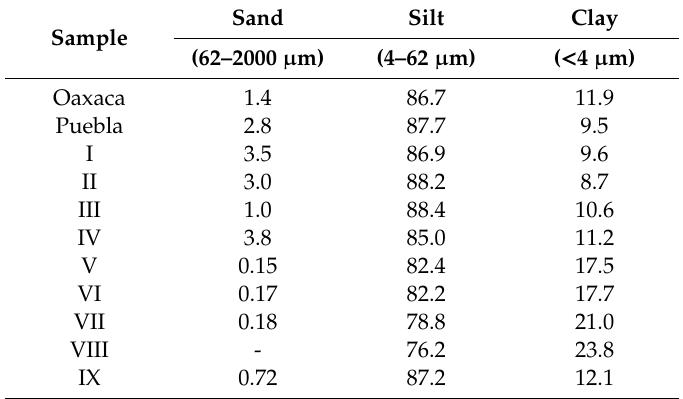
Table 4. Grain size distribution (%) of natural Mexican talc from Oaxaca and Puebla ore deposits and high and low-priced packed